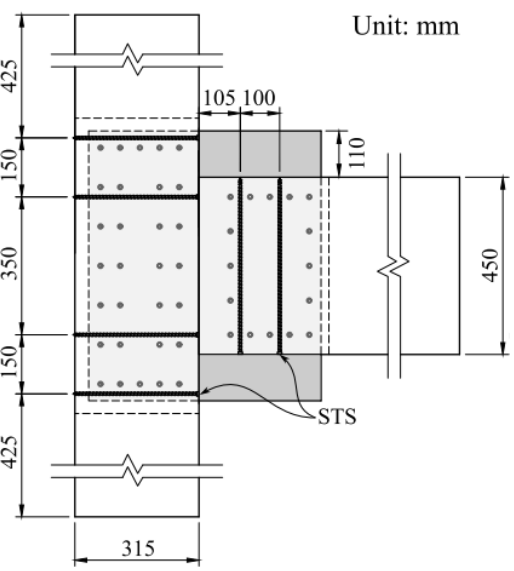
Figure 13. Specimen (Reinforced by STSs under cyclic load), adapted from [36].